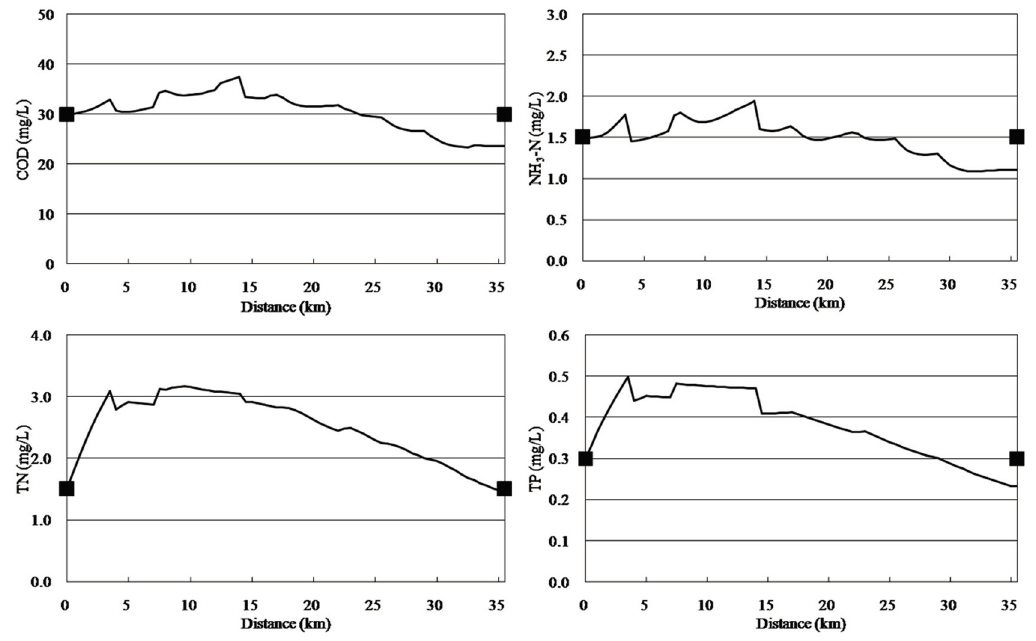
Figure 9. Simulation curves from implementation of river control measures and a pollution load reduction of